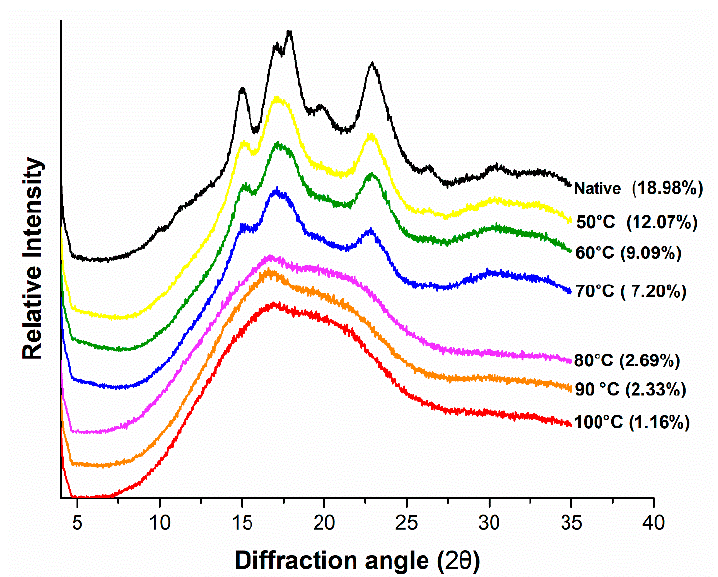
Figure 4. XRD patterns of controlled gelatinized mung bean starch.